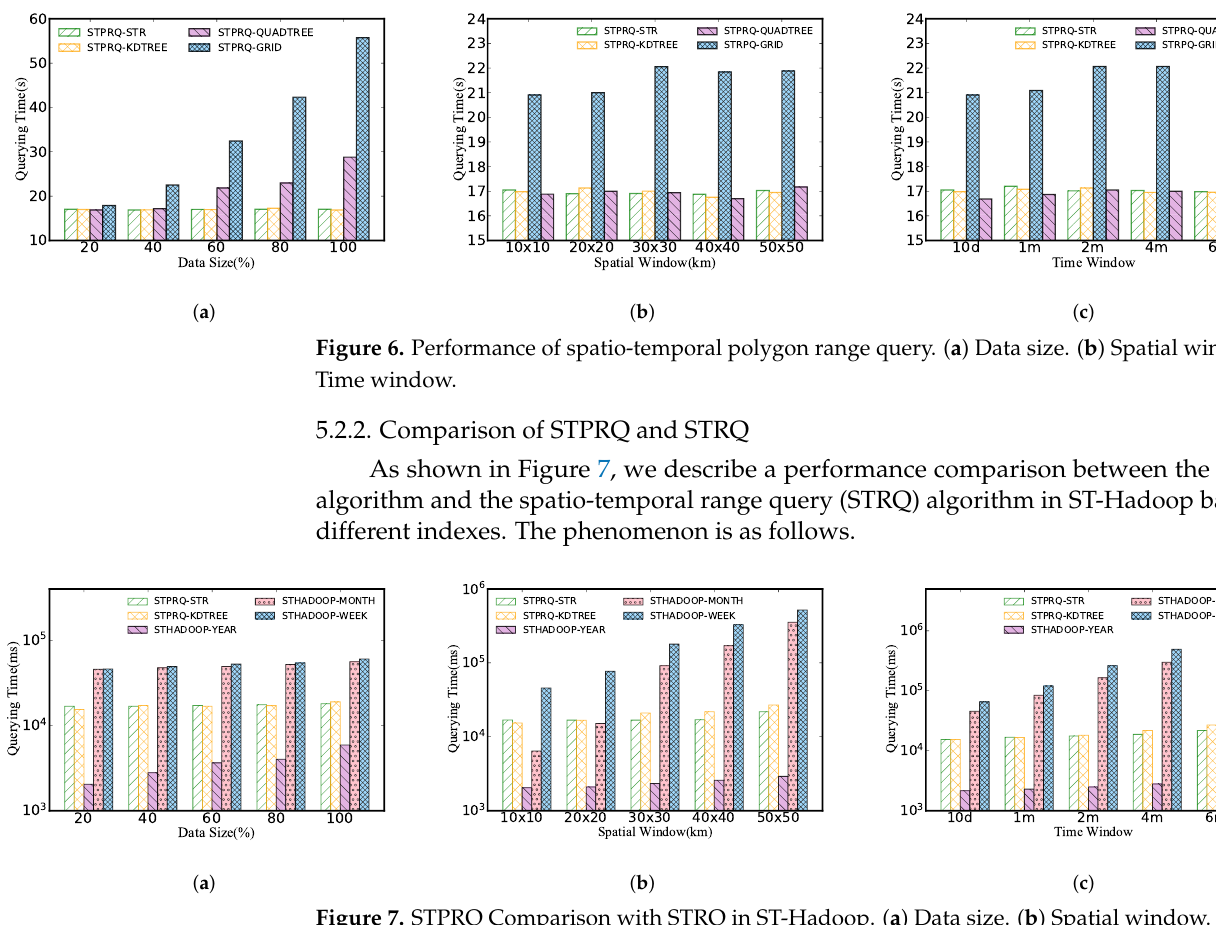
Figure 7. STPRQ Comparison with STRQ in ST-Hadoop. ( a ) Data size. ( b ) Spatial window. ( c ) Time